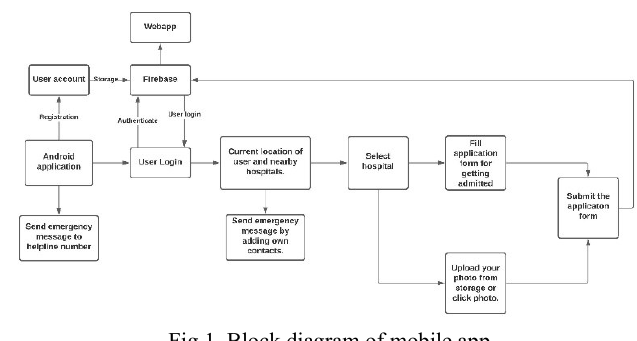
Fig 1. Block diagram of mobile